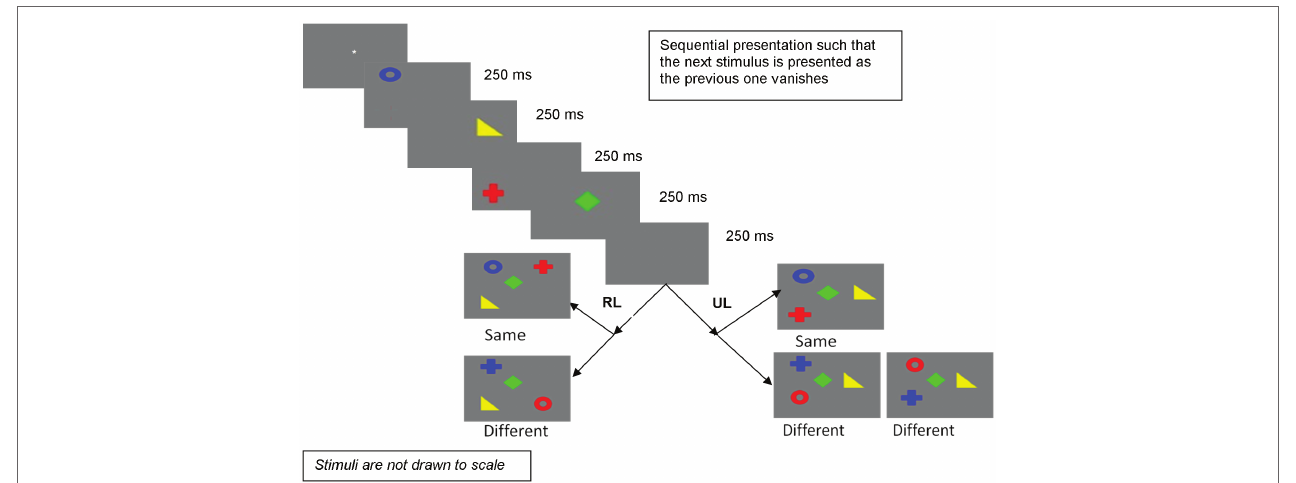
FIGURE 3 | Sequential presentation in Experiment 2 (RL, random locations; UL, unchanged